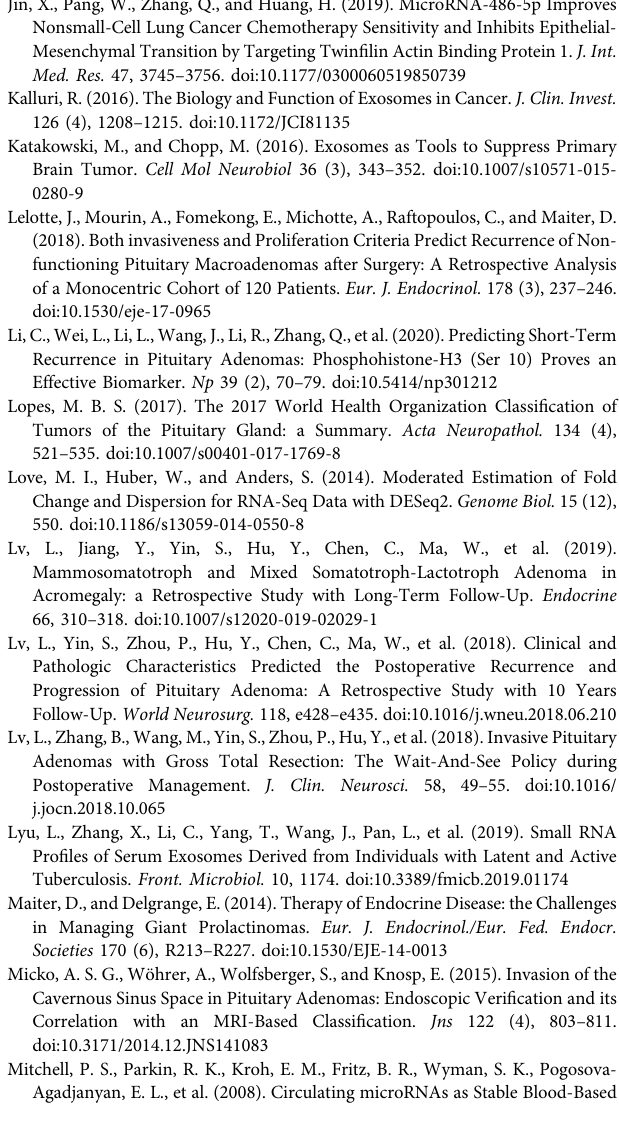
Supplementary Figure S1 | Venn diagram of hub genes cytoHubba plugin selected the top 50 nodes with high degree, high closeness, and high betweenness. Interactive Venn diagram identi fi ed the overlapped hub